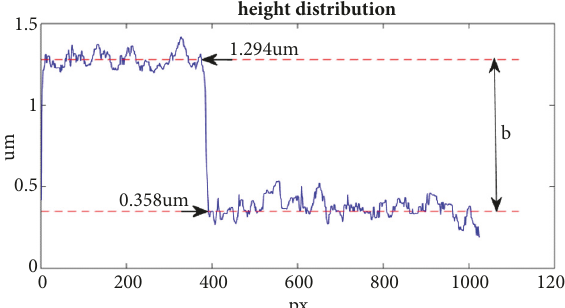
Figure 10: Height distribution values along the middle symmetrical line of groove in Figure